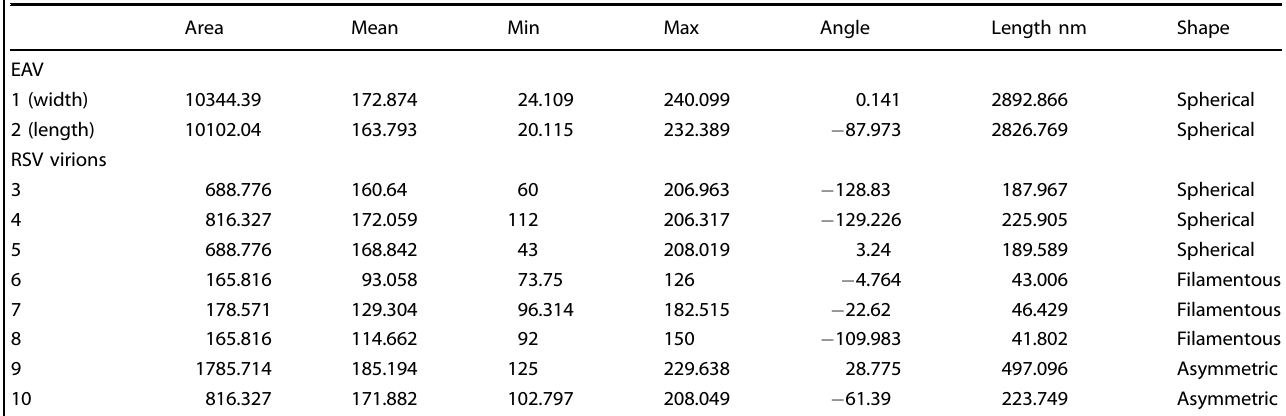
Table 1. Extracellular Amoebal Vesicle (EAV) and internalised RSV virion measurements. Area Mean Min Max Angle Length nm